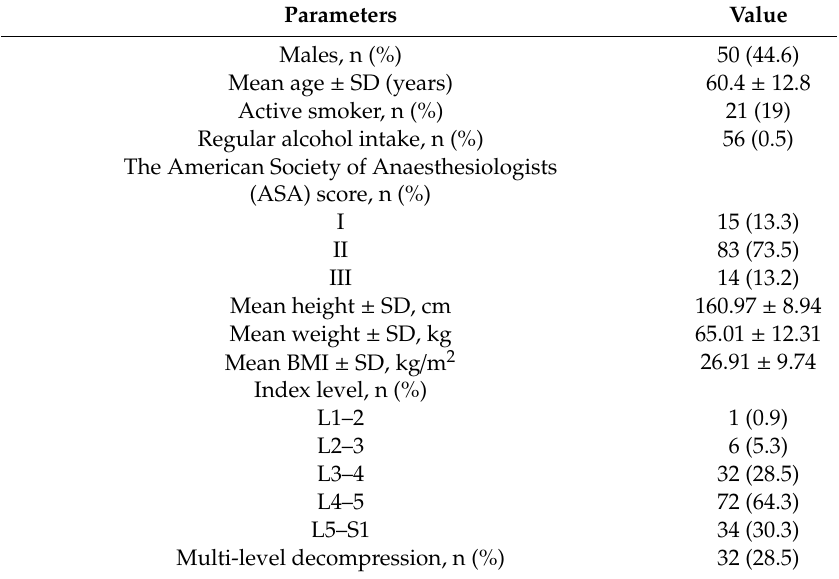
Table 1. General characteristics of patients and parameters ( n = 112)